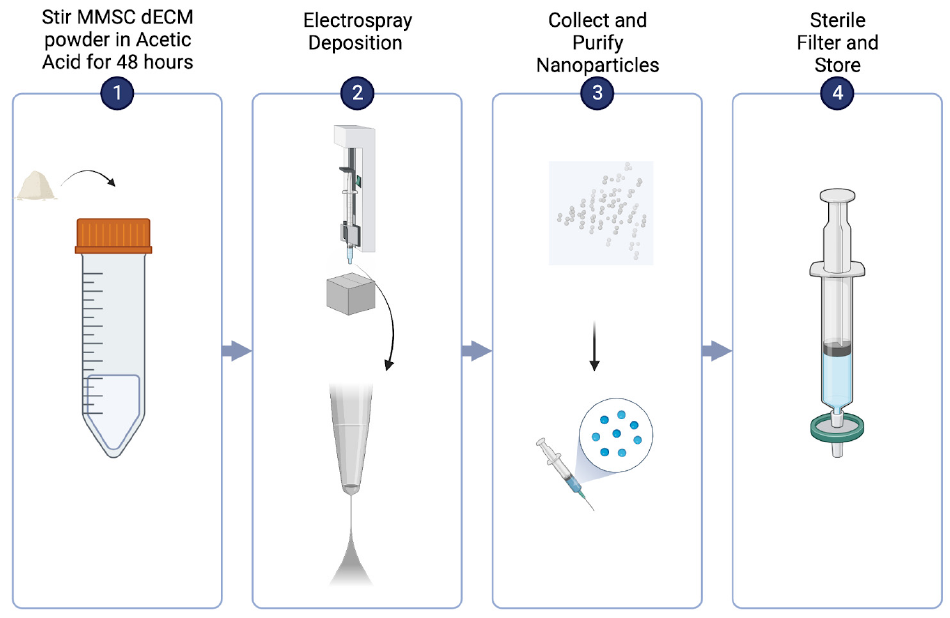
Figure 1. Electrospray deposition procedure.